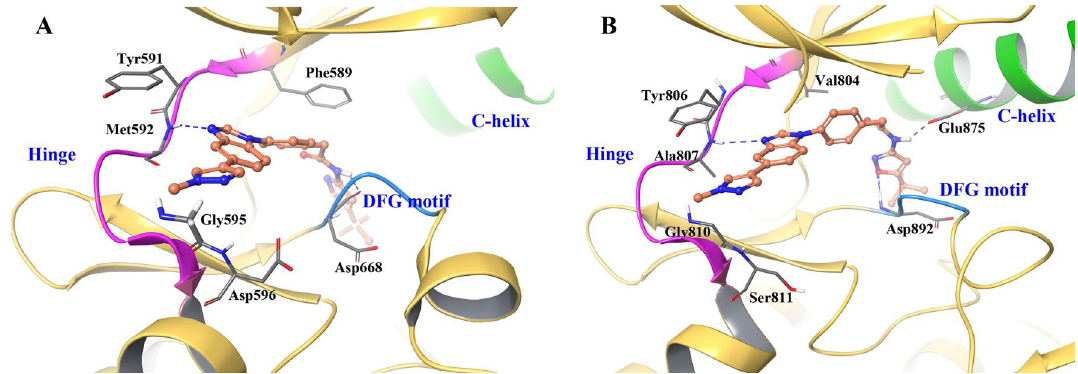
Figure 1. Proposed binding pose and interactions of Pz-1 in TRKA ( A ) and RET ( B ). Kinase structure: yellow ribbons; hinge residues: pink ribbon; DFG residues: blue ribbon; αC-helix: green ribbon; carbon atoms: orange; nitrogen atoms: blue; oxygen atoms: